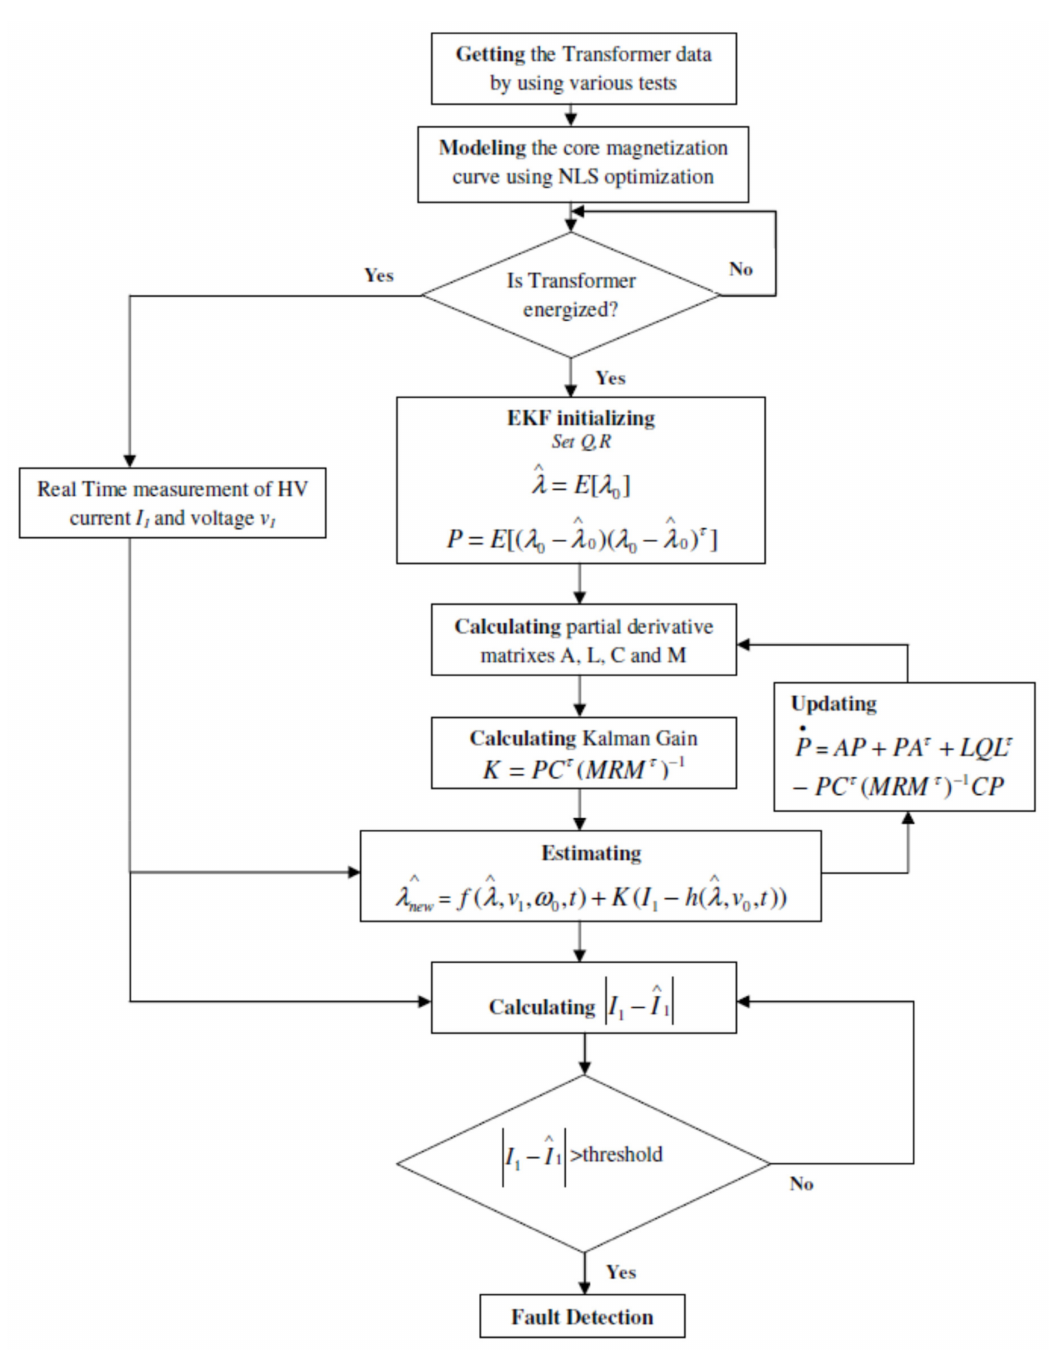
Figure 3. Flowchart of the proposed EKF method for estimation of different fault